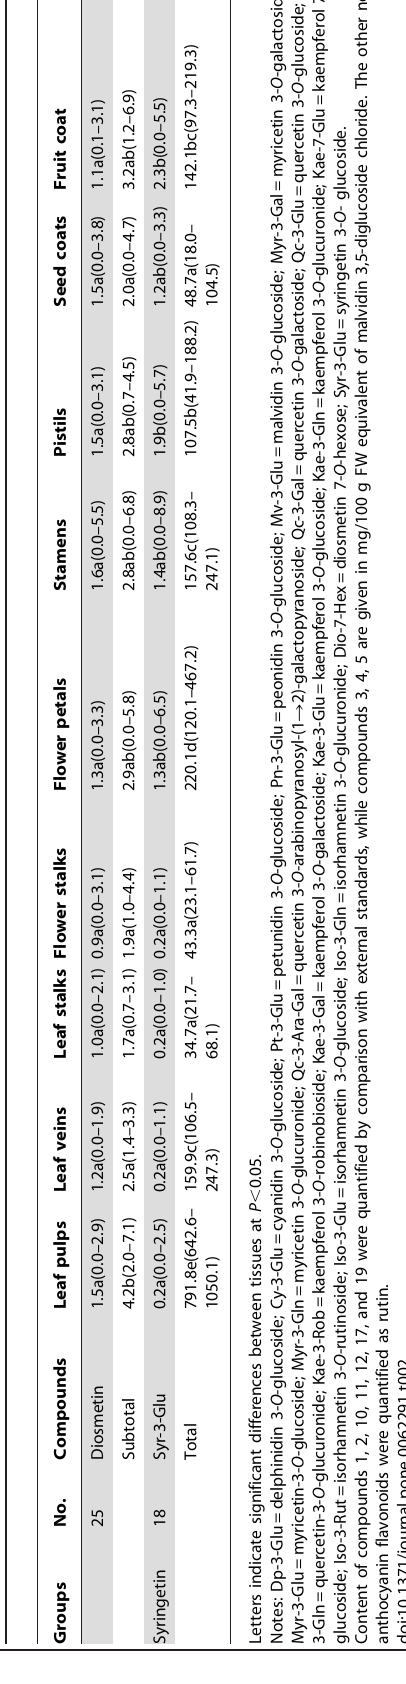
Leaf and flower stalks were the two tissues with the lowest flavonoid concentrations, with respective averages of 34.7 and 43.3 mg/100 g FW (Table 2). The rhizome lotus ‘Zhimahuou’ had the highest content of flavonoids in leaf and flower stalks by a significant margin. Three flower lotus cultivars, ‘Hongshaoyaolian’ (42.2 mg/100 g FW), ‘Ti-1’ (40.5 mg/100 g FW) and ‘Mingmei’ (41.1 mg/100 g FW), had relatively higher total flavonoid contents in leaf stalks. For flower stalk flavonoid concentrations, the seed lotus ‘Xianglian’ (57.8 mg/100 g FW) and N. lutea cultivar ‘Jingque’ (58.8 mg/100 g FW) surpassed ‘Zhimahuou’. The lowest flavonoid contents were detected in leaf and flower stalks of the cultivar ‘Ti-3’.